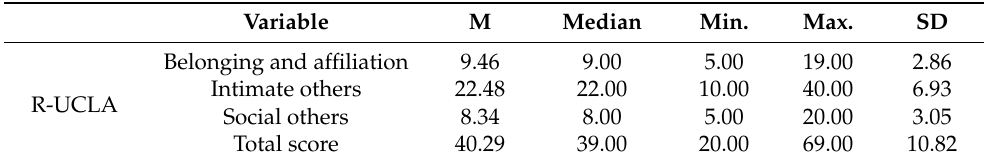
Table 2. R-UCLA scores for loneliness: descriptive statistics.